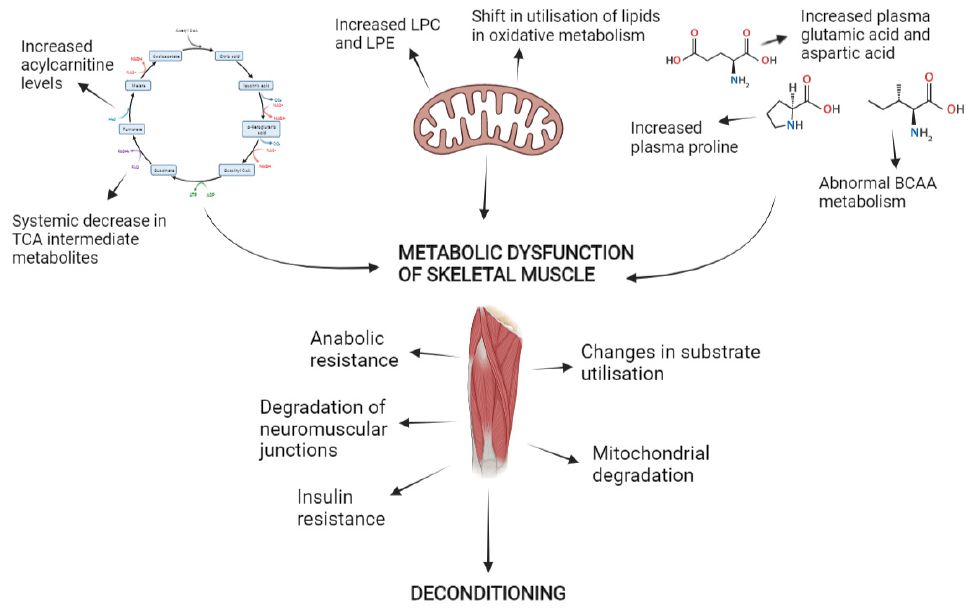
Figure 1. Summary of major findings from untargeted metabolomics work in the development of deconditioning.